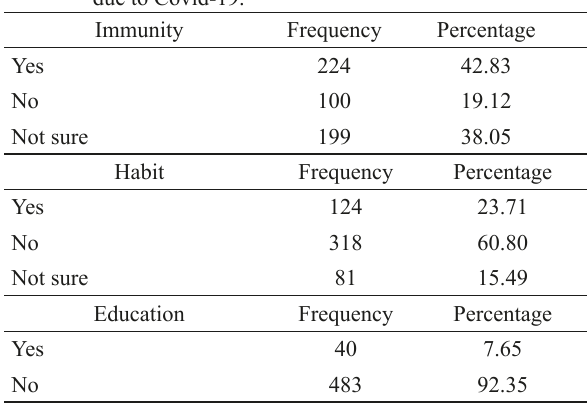
Table 5. Distributions of participants’ opinions on the Effects of Medicinal and Aromatic Plants on Immunity and due to Covid-19.